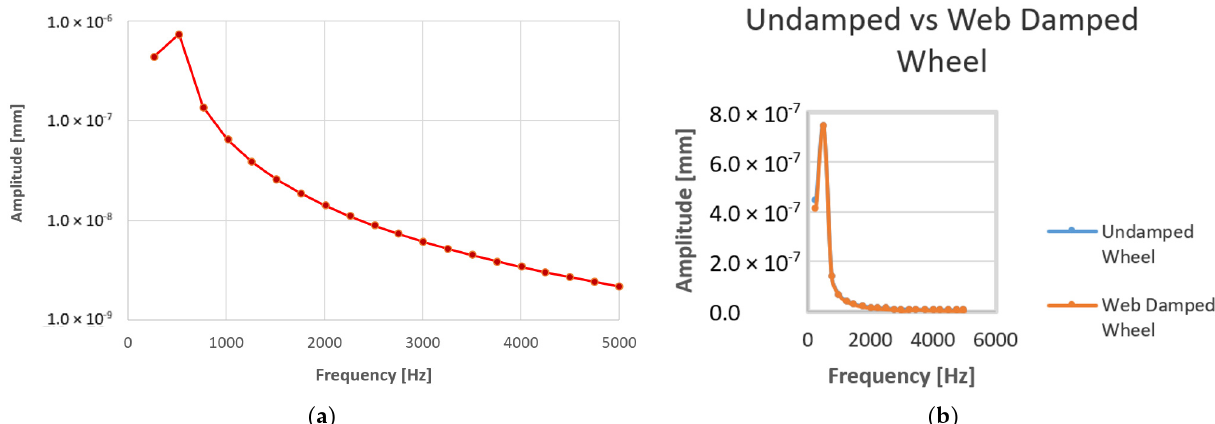
Figure 18. Harmonic response analysis in the lateral direction with viscoelastic damping layer on the web on both sides of the wheel. ( a ) The lateral excitation results of the wheel with viscoelastic layer mounted on the web on both sides of the wheel. ( b ) The lateral excitation of the wheel without (black line) and with viscoelastic layer mounted on the web on both sides.